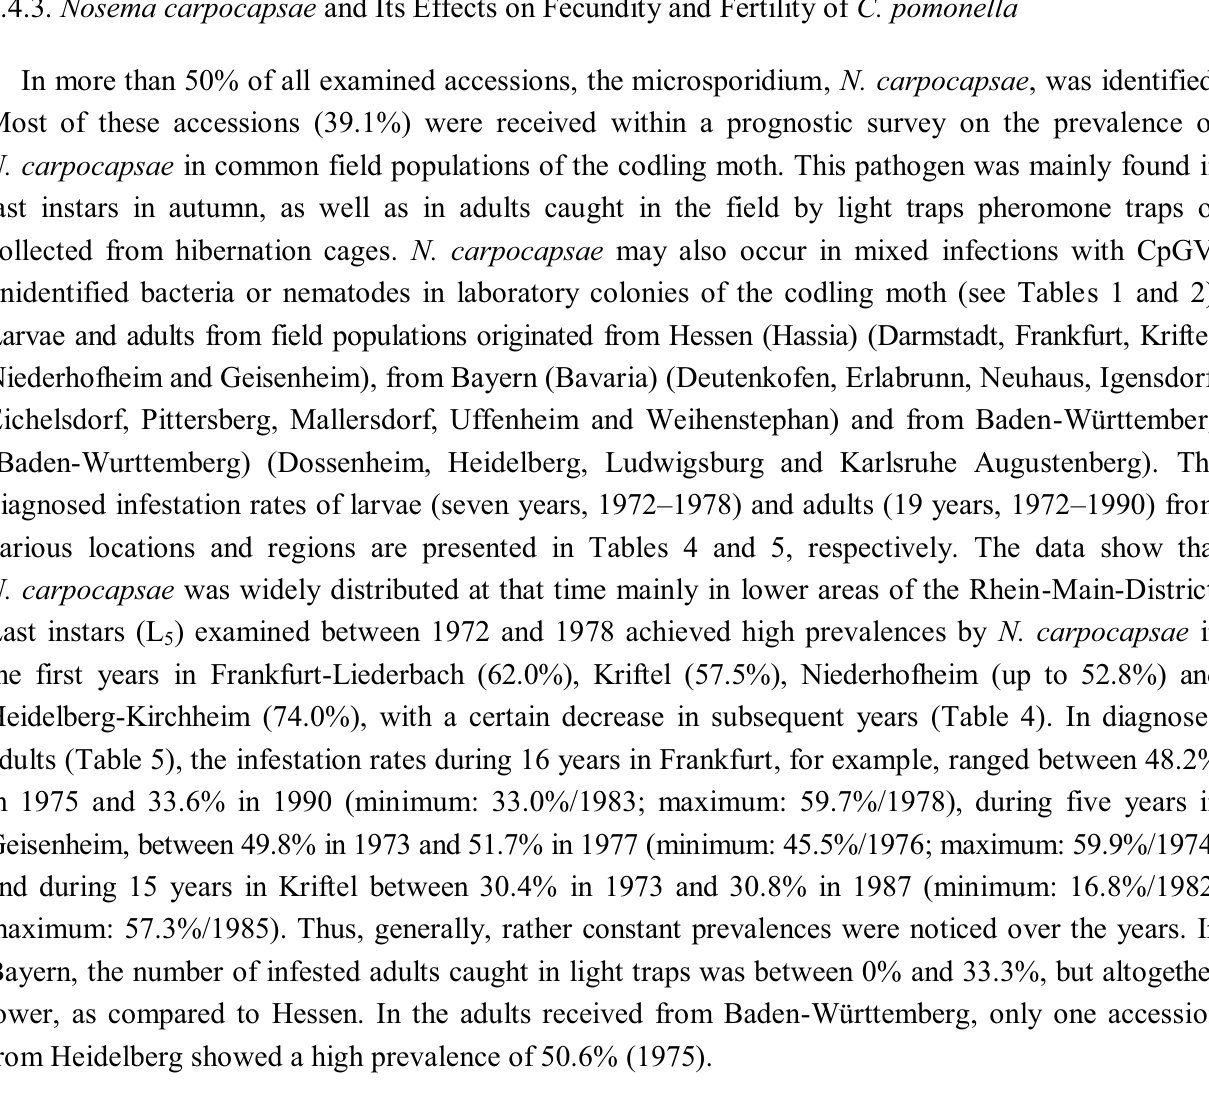
Table 4. Occurrence and prevalence of the microsporidium, Nosema carpocapsae , in larvae of C. pomonella , from various regions in Germany (Hessen, Bayern and Baden-Württemberg; 1972 (cid:177)